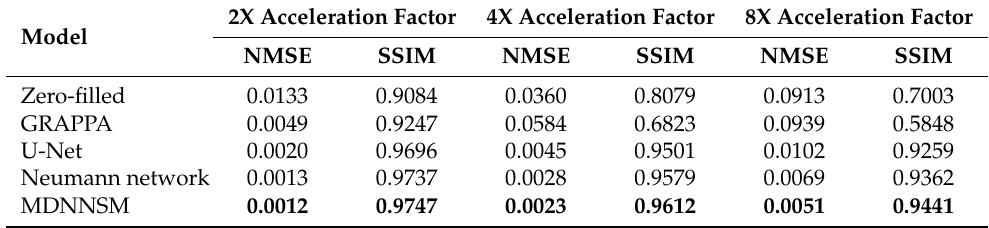
Table 1. Quantitative evaluation of reconstructed T1-weighted images with acceleration factors of 2, 4, and 8.